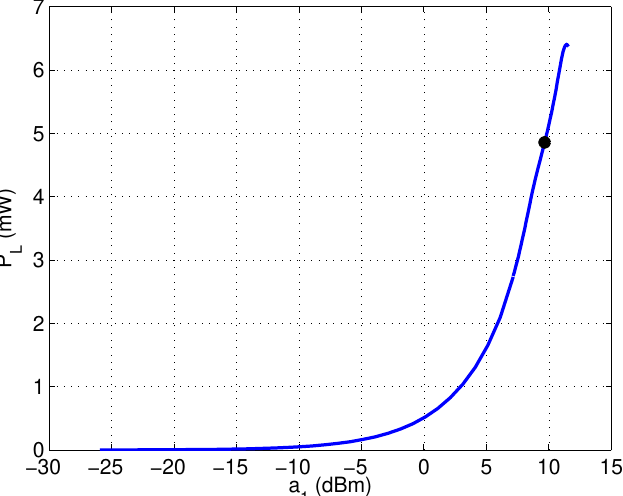
and B (cid:48) extraction. IN , S IN , S